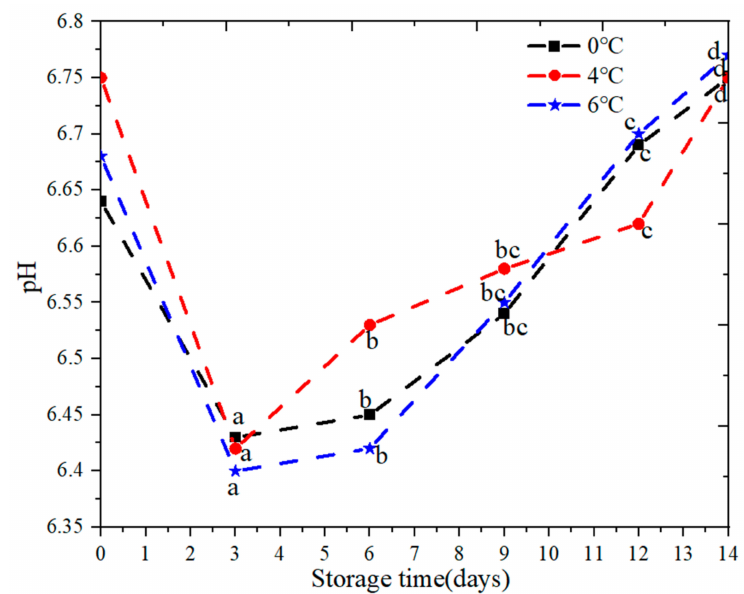
Figure 8. pH change of salmon samples stored at refrigerated temperature (0 ◦ C, 4 ◦ C, 6 ◦ C) for 14 days. Note: di ff erent letters indicate significant ( p < 0.05) di ff erences.